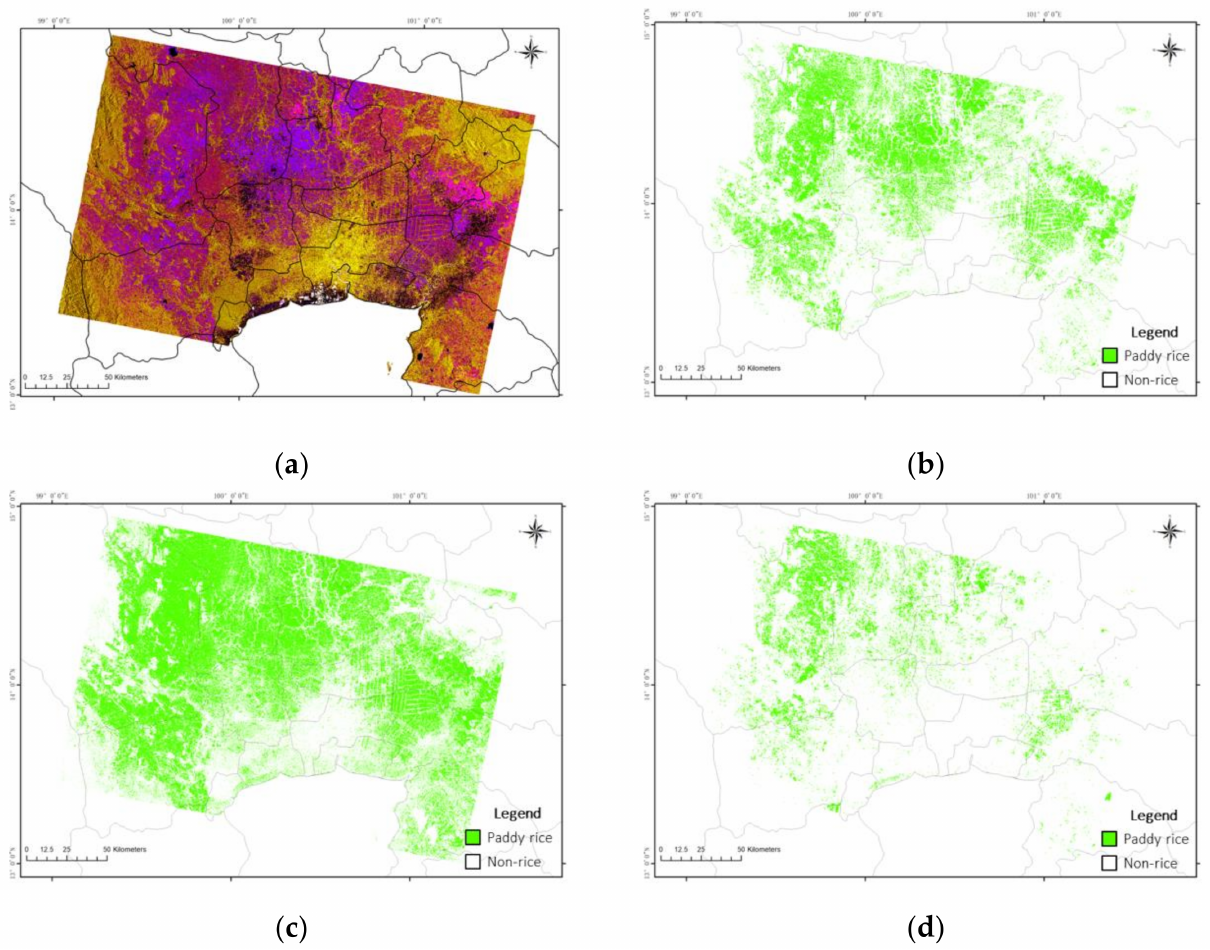
Figure 23. The paddy rice mapping results of different methods: ( a ) false-color image of the temporal features of frame 62-4; ( b ) paddy rice mapping result of the proposed method; ( c ) paddy rice mapping result of the SVM classifier; ( d ) paddy rice mapping result of the FS-U-Net